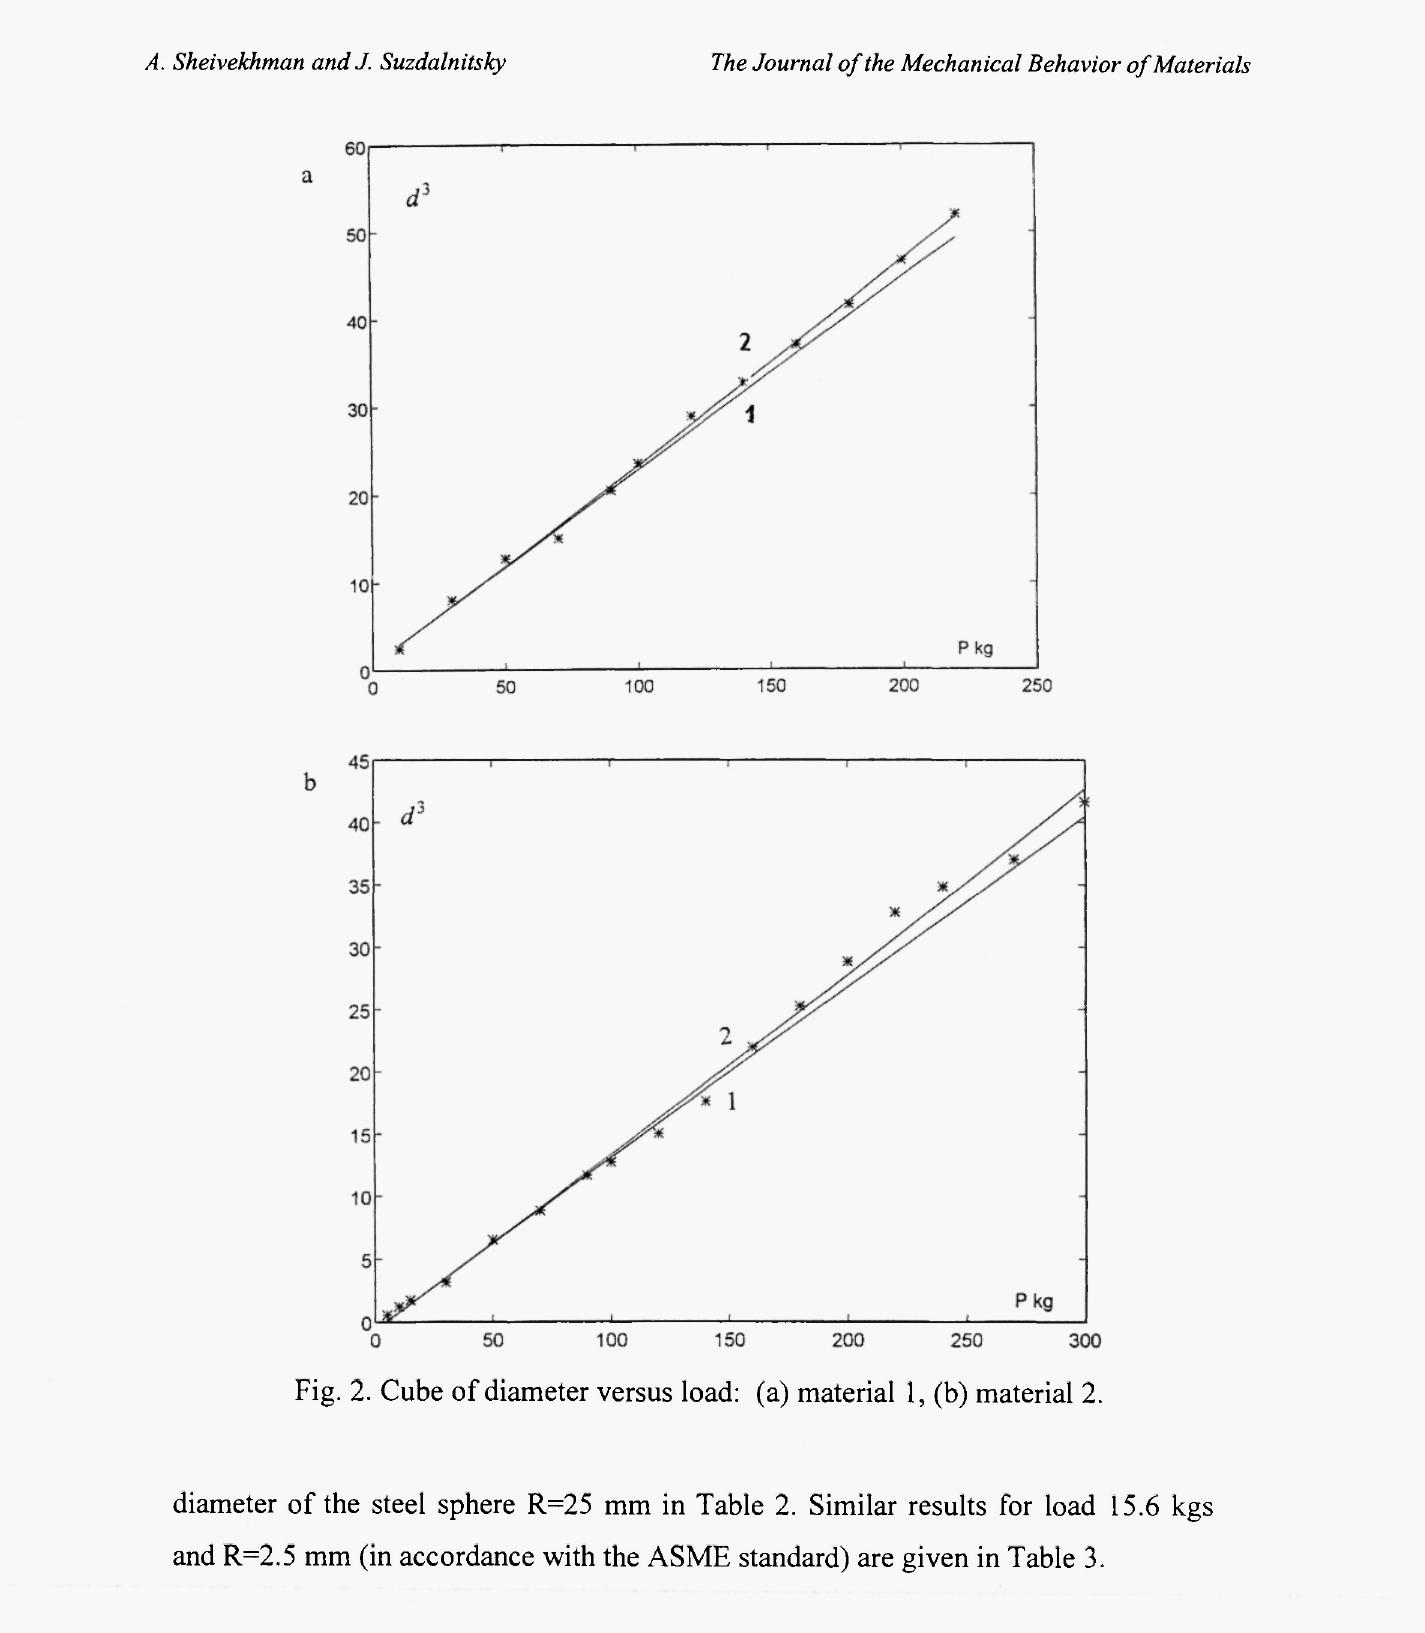
diameter of the steel sphere R=25 mm in Table 2. Similar results for load 15.6 kgs and R=2.5 mm (in accordance with the ASME standard) are given in Table